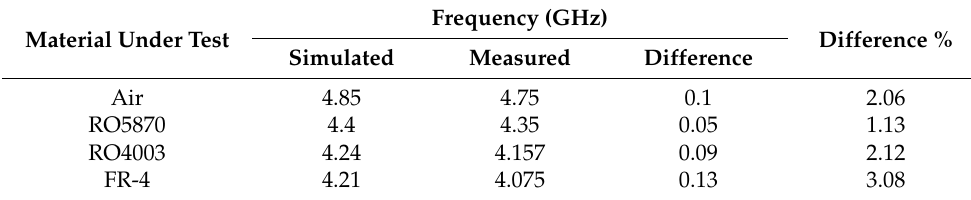
Table 4. Comparison of simulated and measured results with three standard materials under test